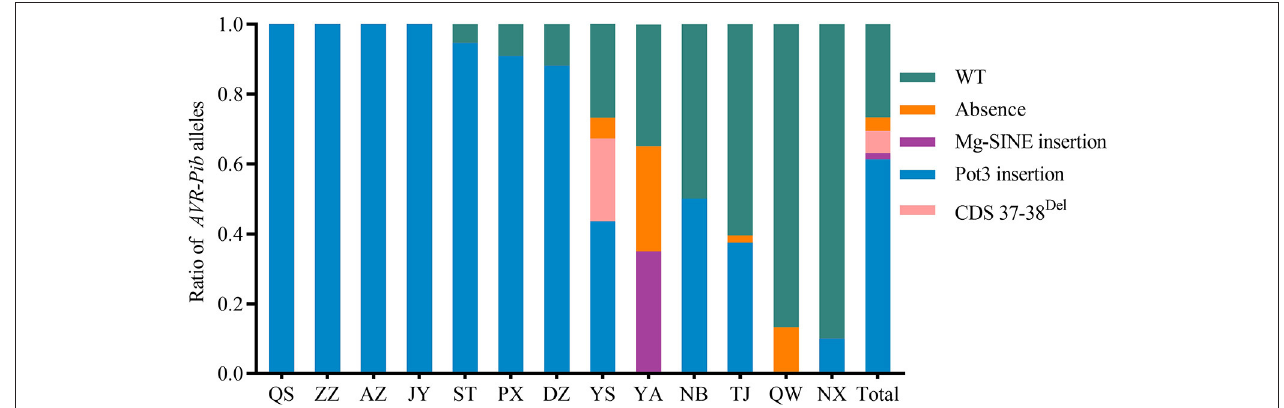
FIGURE 4 | Distribution of isolates carrying variants of invalid AVR-Pib in 13 nurseries of the Sichuan Basin. Four variants, namely, absence, Mg-SINE insertion, Pot3 insertion, and coding sequence (CDS) 37-38 Del , which caused function loss of AVR-Pib . Wild type (WT) denotes isolates have similar amplification size of AVR-Pib WT. Although some of variants may exist short insertions in the promoter of AVR-Pib , it is still avirulence to the monogenic line IRBLb-B carrying Pib .